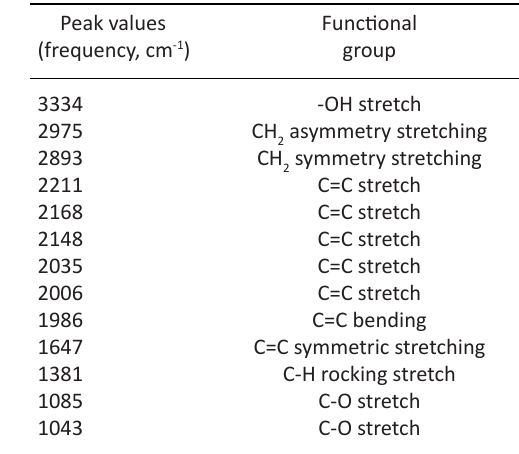
seeds: Acetone extracts Peak